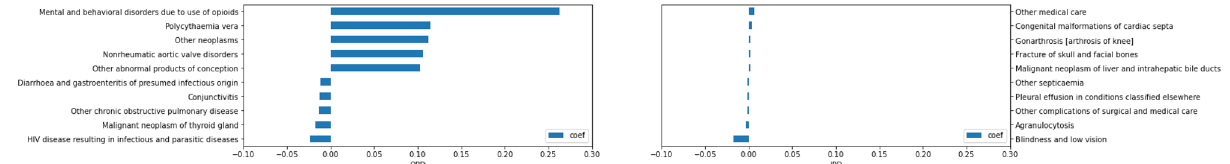
Figure 2. HAD binary classification: Feature importance in OPD and IPD data sets.